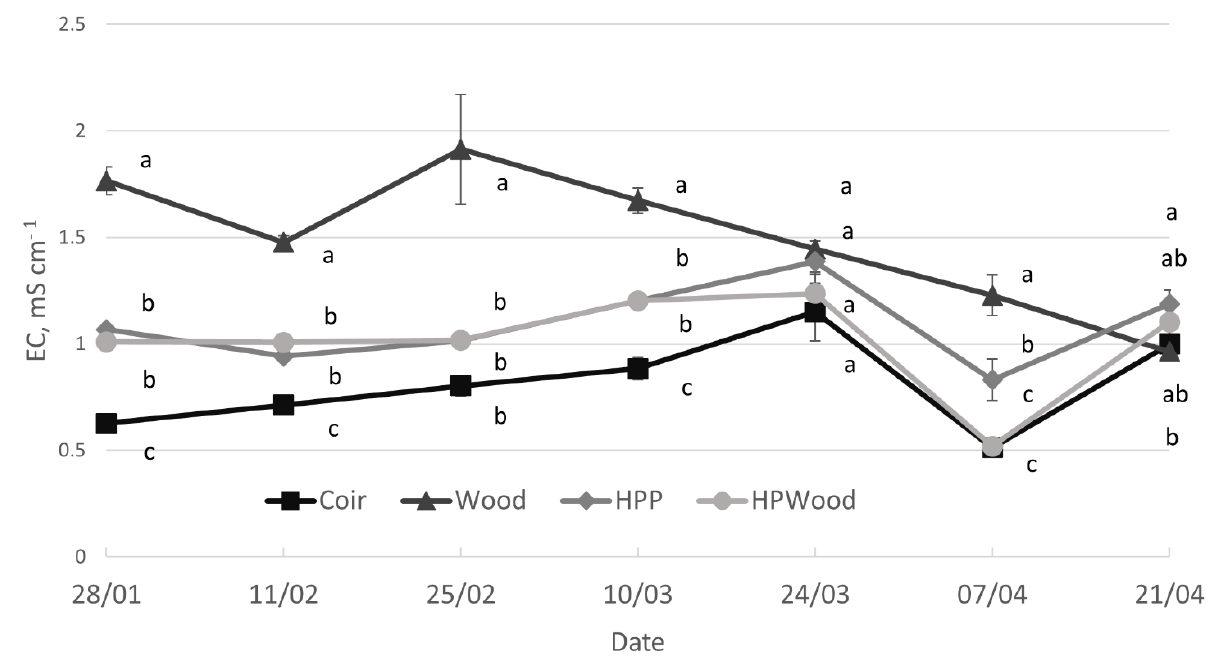
Figure 2. Time series of EC in drainage water collected from the Bottom level of arctic bramble plant towers with different substrates. Vertical bars present ± SE (n = 6). Different lowercase letters indicate statistically significant differences between the substrates at each date (P <0.05) by Tukey’s test.